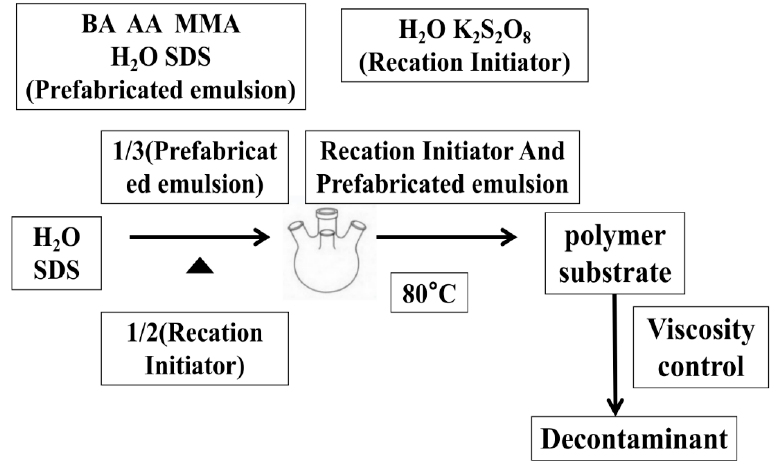
Figure 2. Flowchart of decontaminant preparation.